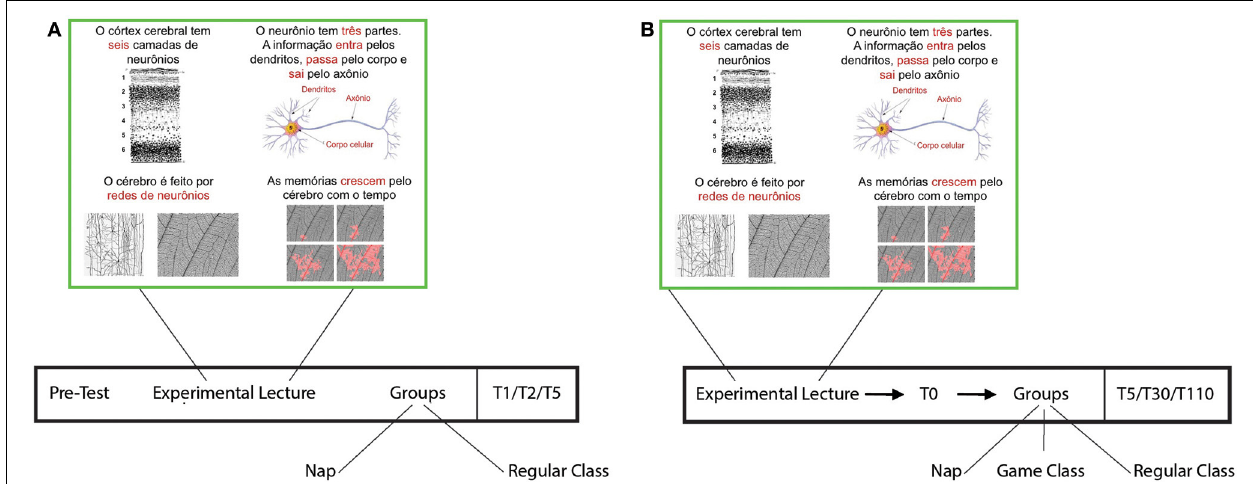
FIGURE 1 | Experimental design. Students were exposed to a lecture on novel declarative contents, sorted to nap or not to nap, and subjected to surprise tests after 1, 2, and 5 days. (A) Experiment I. (B) Experiment II. ∗ Indicates significant differences with respect to the pre-test.